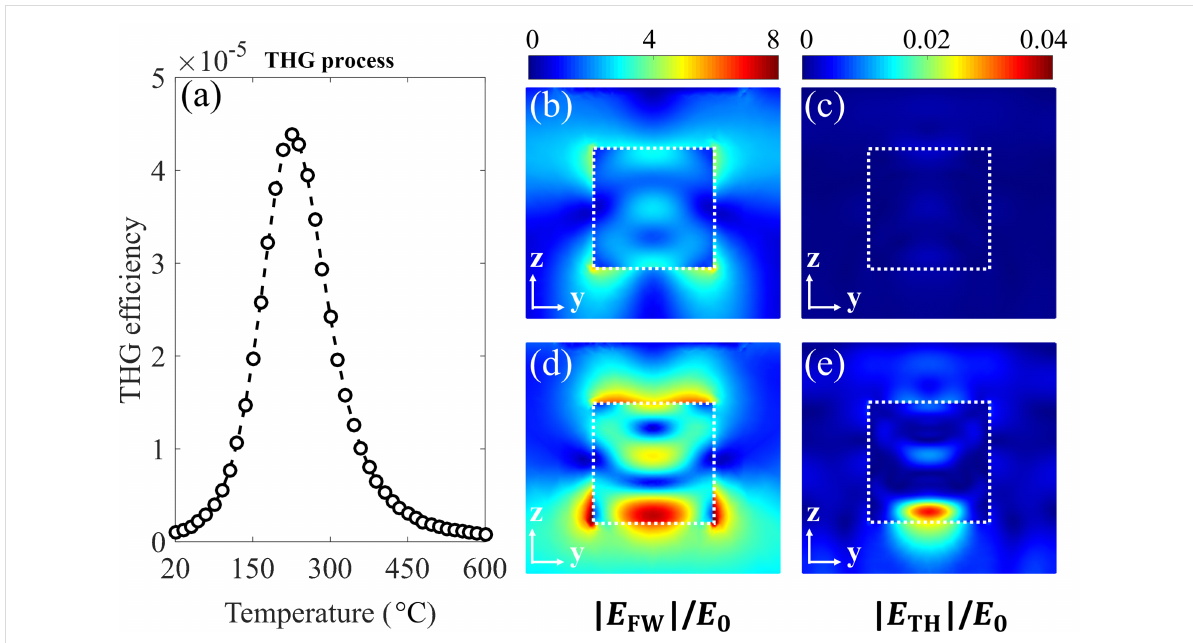
Figure 6: (a) Third harmonic generation efficiency (normalized by the incident pump for each unit cell) during the heating process pumped at the wavelength of 1235 nm. (b) and (c) show the electric near-field distributions at fundamental (left) and harmonic (right) wavelengths in the silicon disk at room temperature, respectively. (d) and (e) show the related calculations after heating the sample at 275